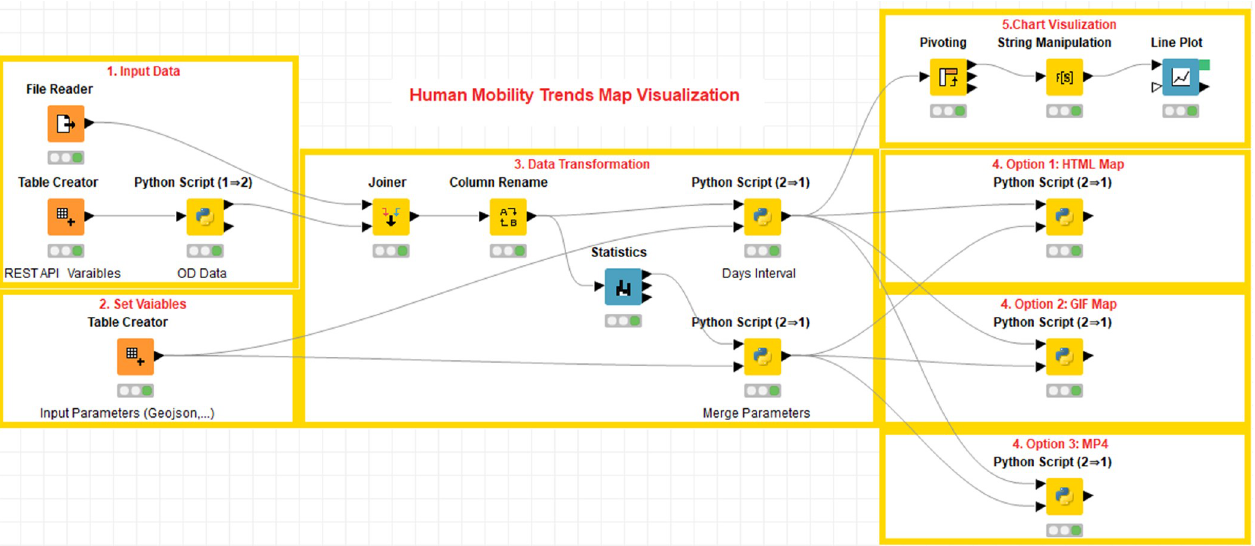
data. More importantly, to make the data replicable, users only need to change input variables settings (e.g., change to different time periods) without extra operations. Fig 10 displays the interactive dynamic map visualization results and compares the intra-state human mobilities differences before and during the early stage of the COVID-19 pandemic in the U.S. The left map displays the choropleth map of intra-state human mobilities as of March 6, 2020, while